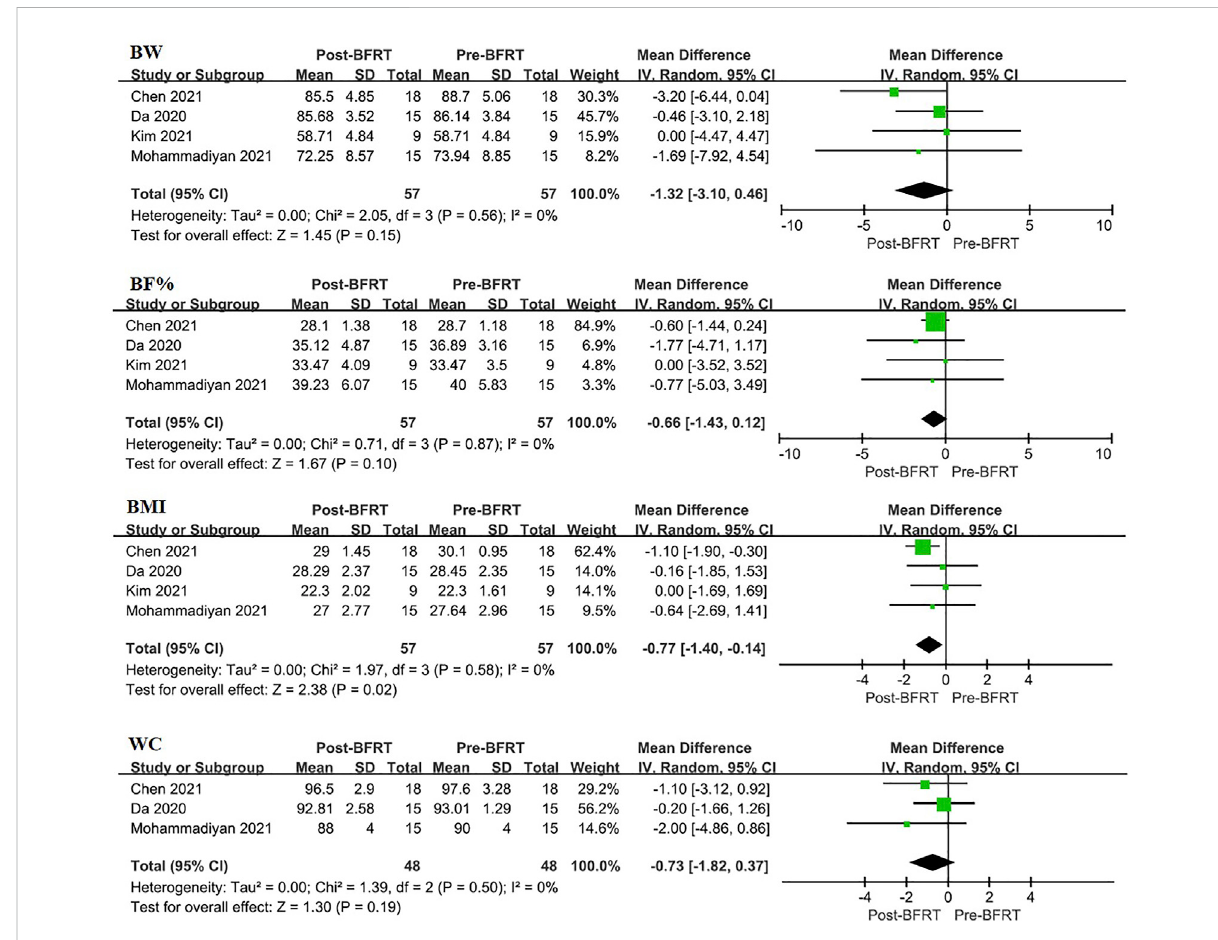
FIGURE 3 Forest plot displaying thedifference in anthropometric indicators between experimental group and control group for each individual case. BW, body weight; BF%, body fat percentage; WC, waist